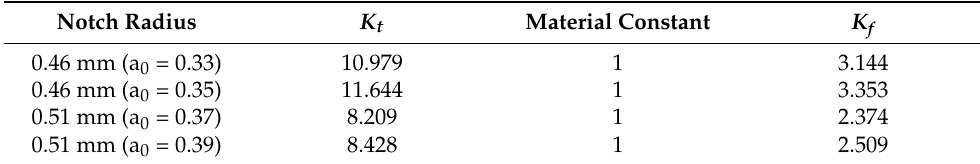
Table 2. Parameters of notch radius/ K t /material constant/ K f .